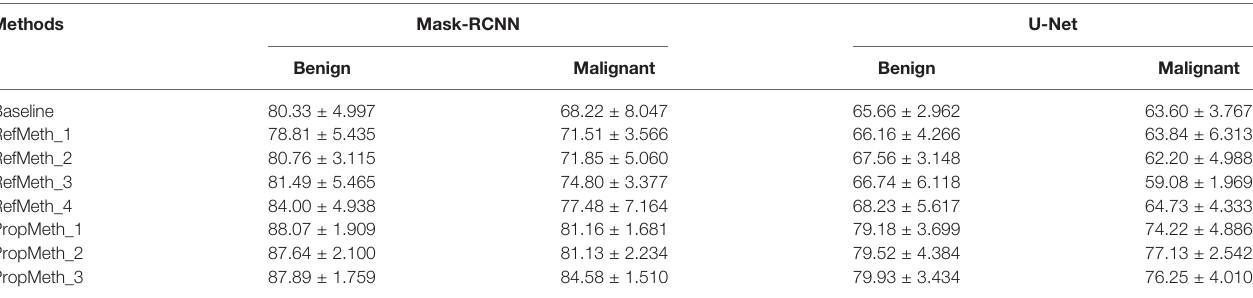
TABLE 4 | Segmentation performance evaluation between benign and malignant tumors in DSC(%).